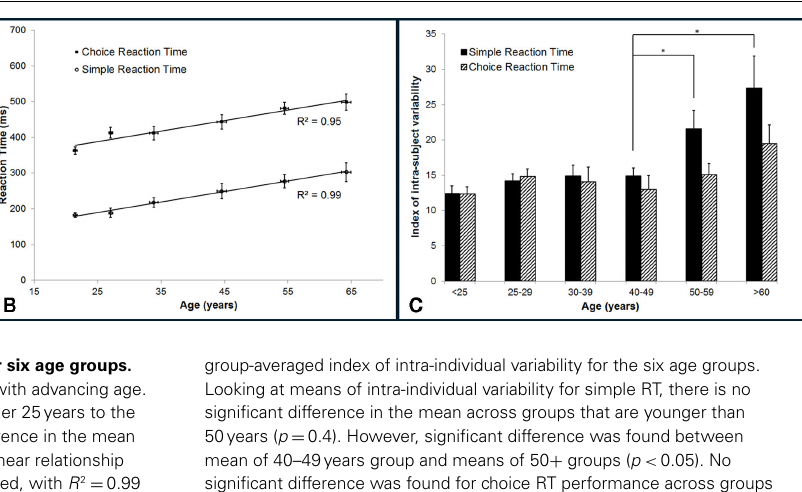
group-averaged index of intra-individual variability for the six age groups. Looking at means of intra-individual variability for simple RT, there is no significant difference in the mean across groups that are younger than 50years ( p = 0.4). However, significant difference was found between mean of 40–49years group and means of 50 + groups ( p < 0.05). No significant difference was found for choice RT performance across groups ( p =